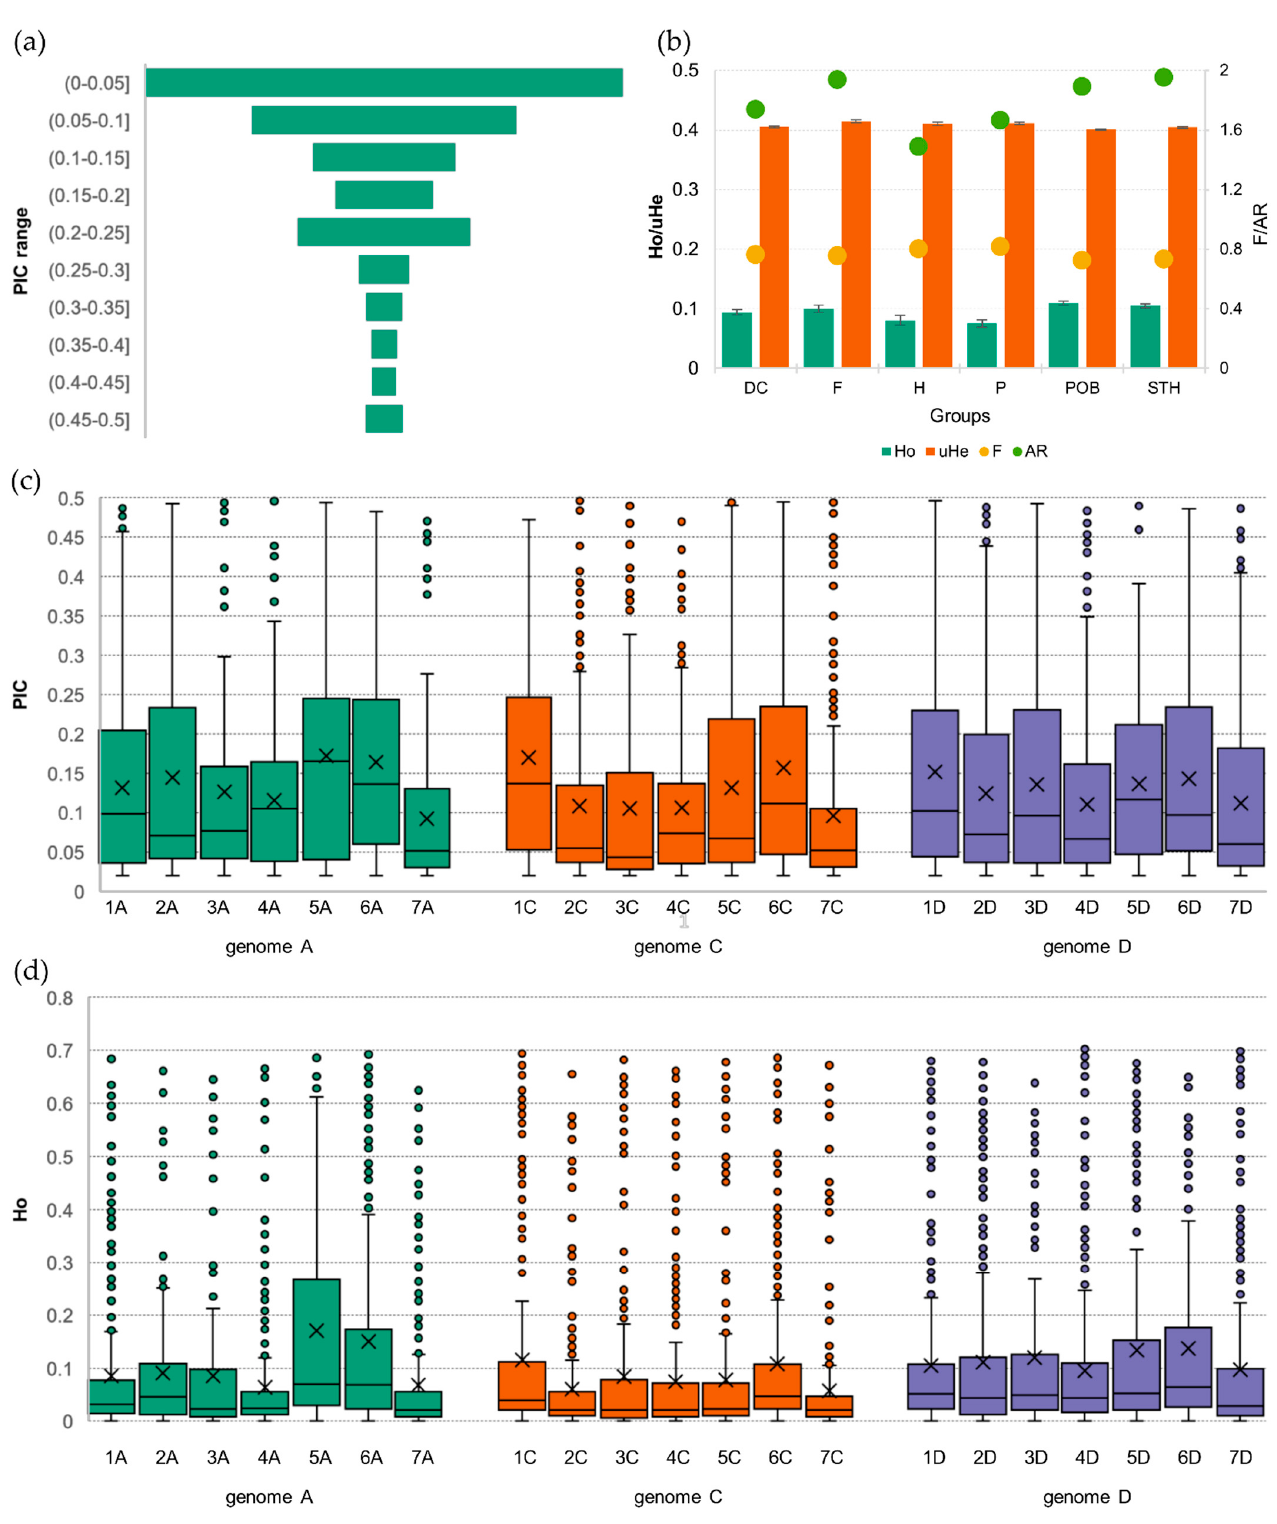
Figure 2. Summary of coefficients for 487 accessions of A. sativa ; ( a ) polymorphic information content (PIC); ( b ) diversity coefficients: heterogeneity (Ho) and expected heterozygosity (He), inbreeding factor (F) and allelic richness (AR); ( c ) PIC by chromosome; and ( d ) heterogeneity by chromosome. level, showed that the maximum Ho in foreign cultivars (F) and breeding materials from Małopolska Plant Breeding Ltd. (POB), Strzelce Plant Breeding Ltd. (STH), and